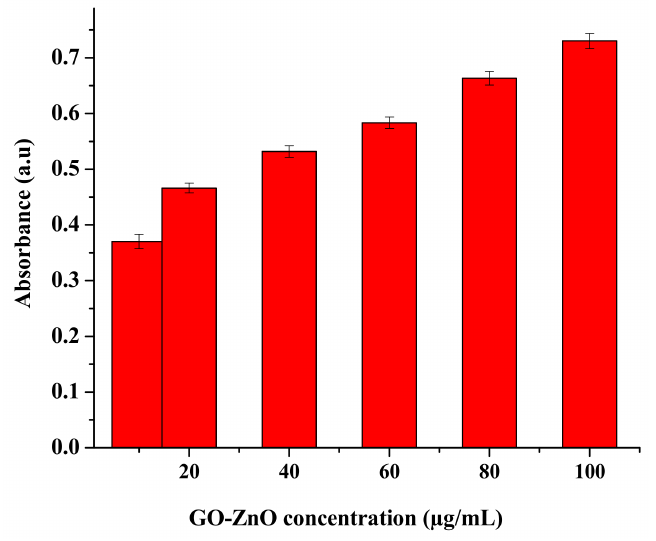
Figure 5. Absorbance versus concentration of GO-ZnO